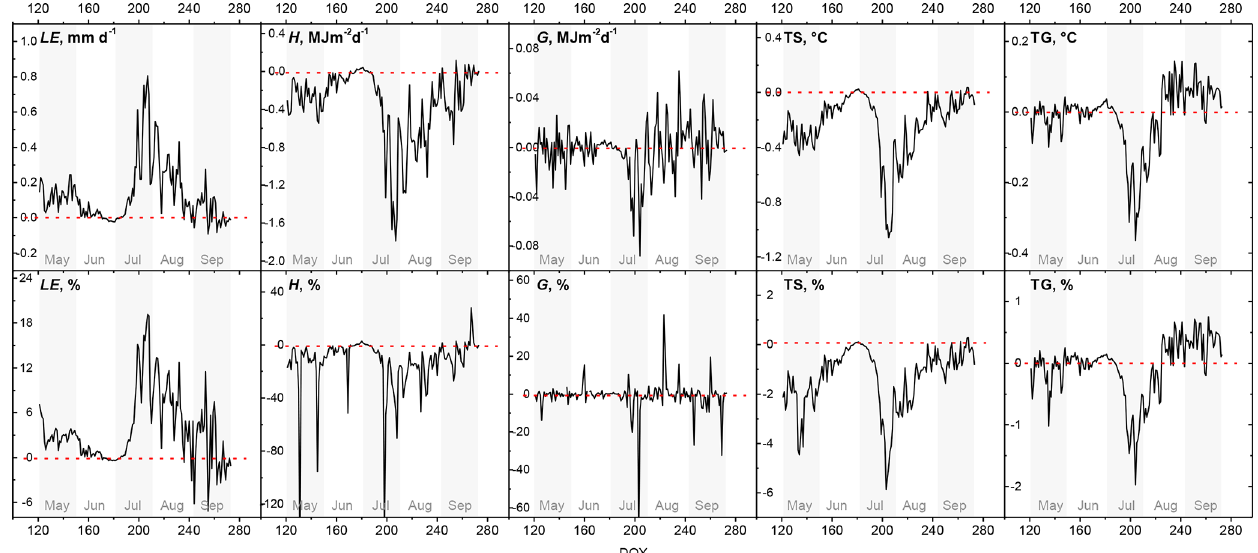
Figure 6. Differences in latent heat flux ( LE ), sensible heat flux ( H ), ground heat flux ( G ), mean surface temperature (TS) and mean ground temperature (TG) between Run 1 and Run 2 simulations (Run 1–Run 2). Given percentages are relative differences between Run 1 and Run 2 simulations.